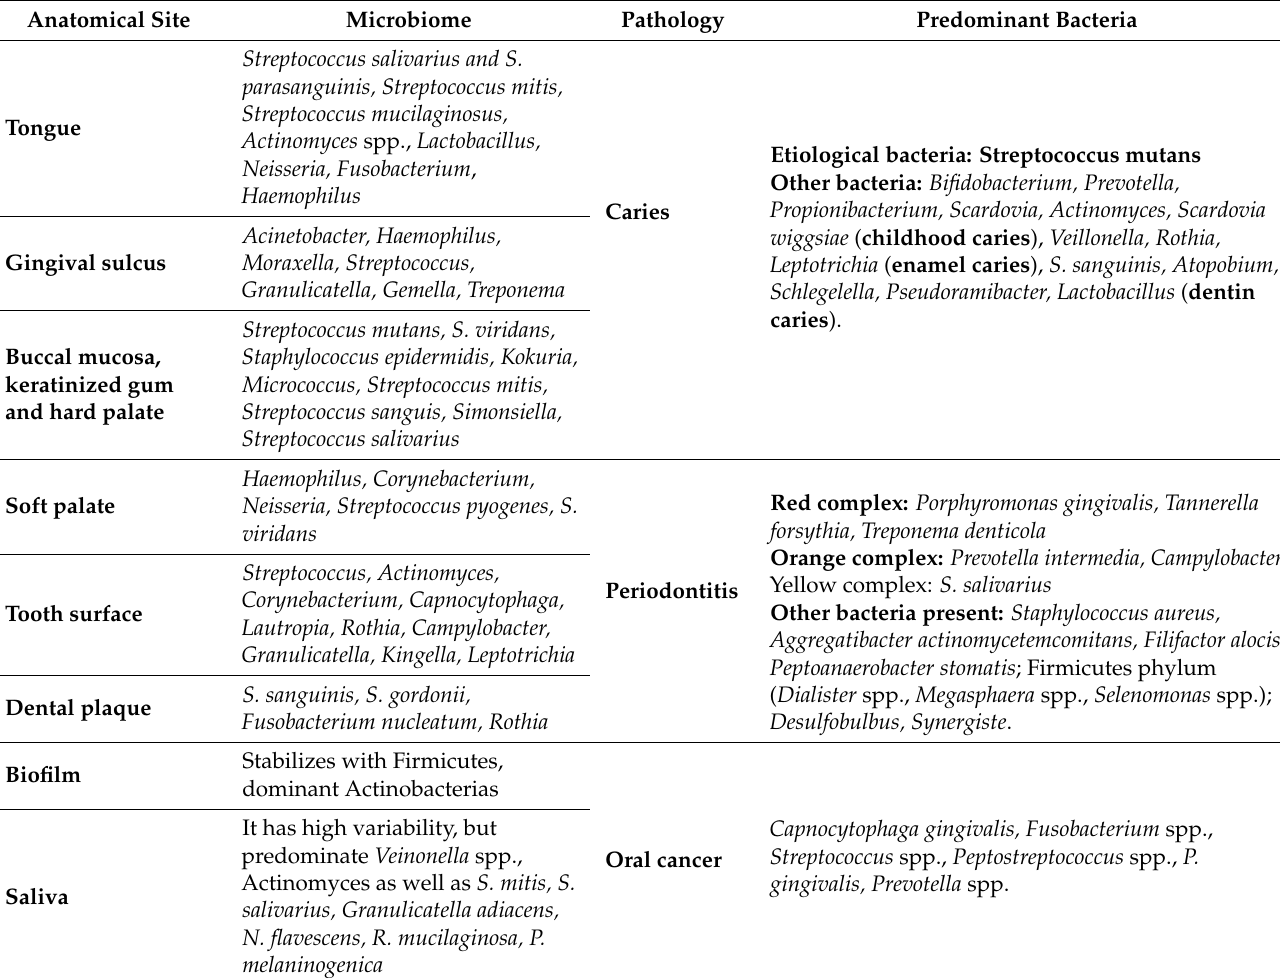
Table 2. Microbiome of the oral cavity and oral